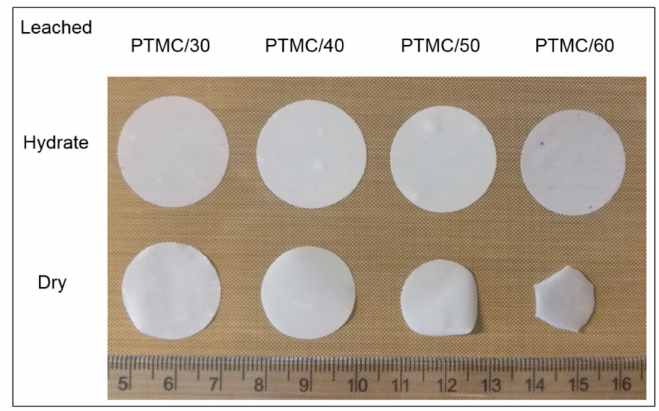
Figure 4. Macroscopic images of leached PTMC / CaCO 3 composite films in hydrated and dry